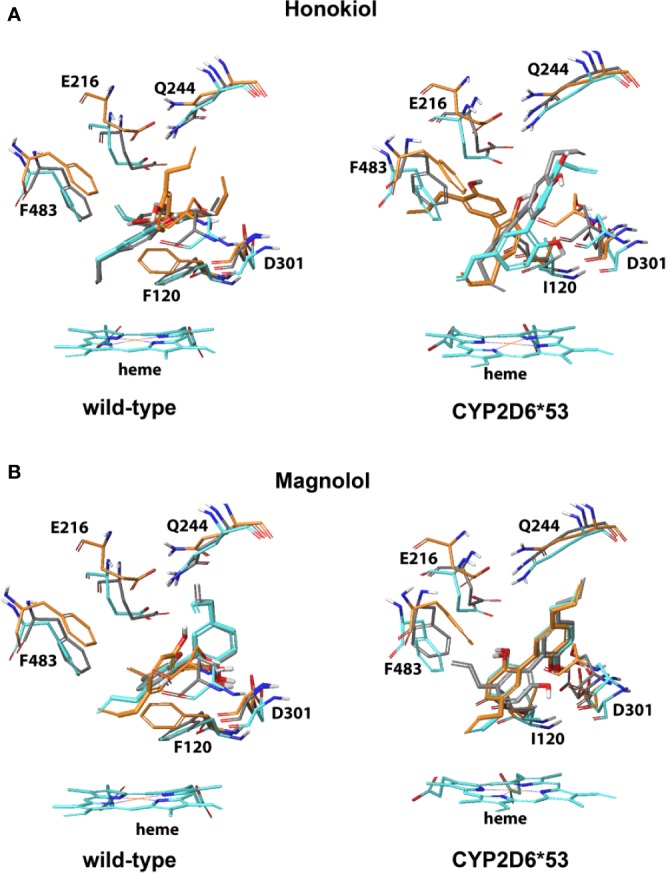
CYP2D6 wild-type and CYP2D6*53 inhibition binding modes for (A) Honokiol and (B) Magnolol. The best scored poses are shown docked into 4WNW (cyan), 4WNU (orange) and 4WNT (grey). To keep a clear overview, only the interacting residues are displayed and labeled and solely the heme of 4WNW is displayed.